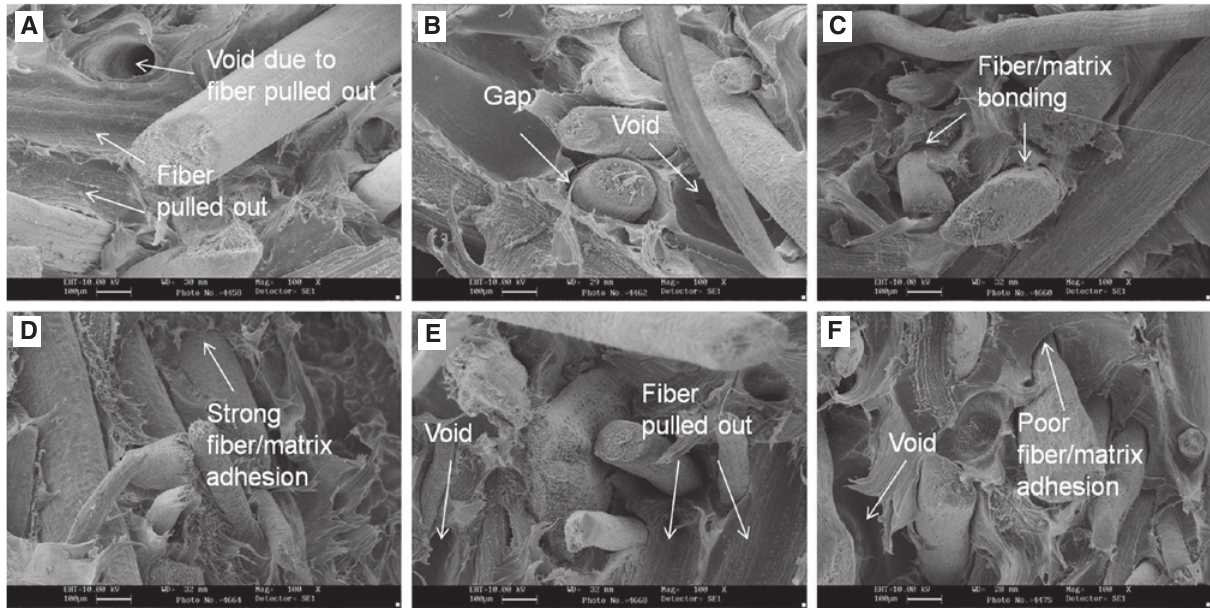
Figure 10: SEM micrographs of fracture surface of the CF/LDPE (20 wt% fiber loading) composite: (A) CF/LDPE, (B) A-CF/LDPE, (C) AA-CF/ LDPE, (D) CF/MA-g-LDPE/LDPE, (E) A-CF/MA-g-LDPE/LDPE, and (F)